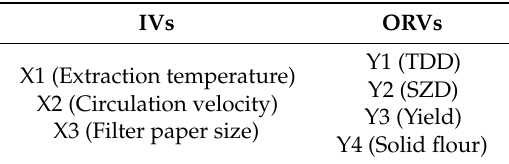
Table 1. Input variables (IVs) and output response variables (ORVs) derived from QFD.